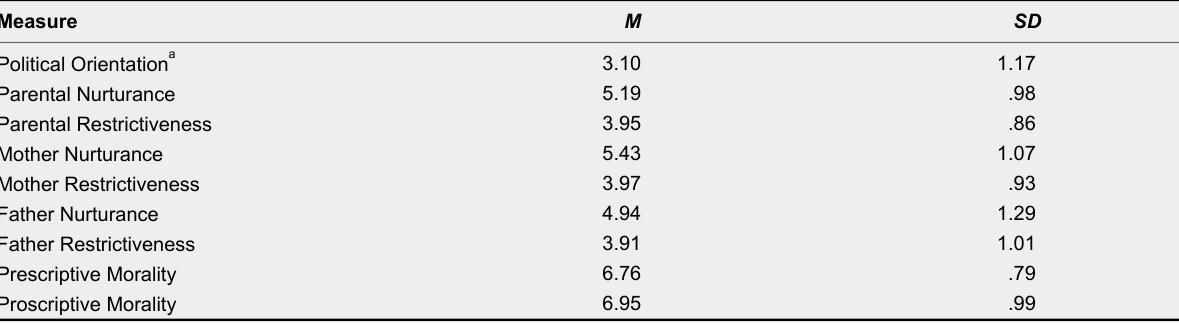
Means and Standard Deviations of Study 2